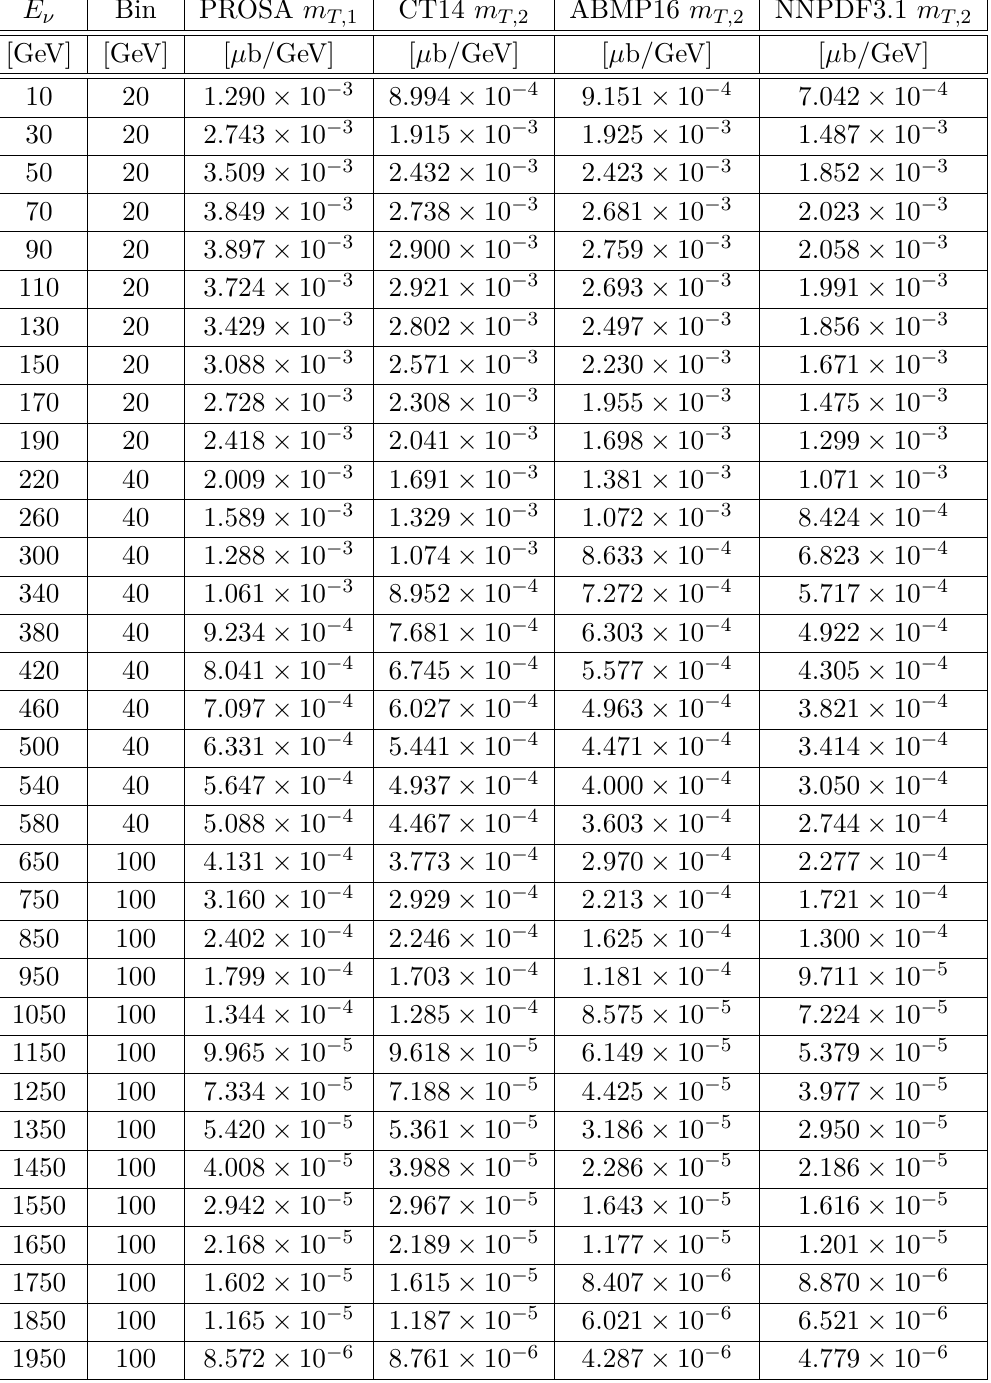
√ for s = 14 TeV, 7 . 2 < η ν < 8 . 6 . s